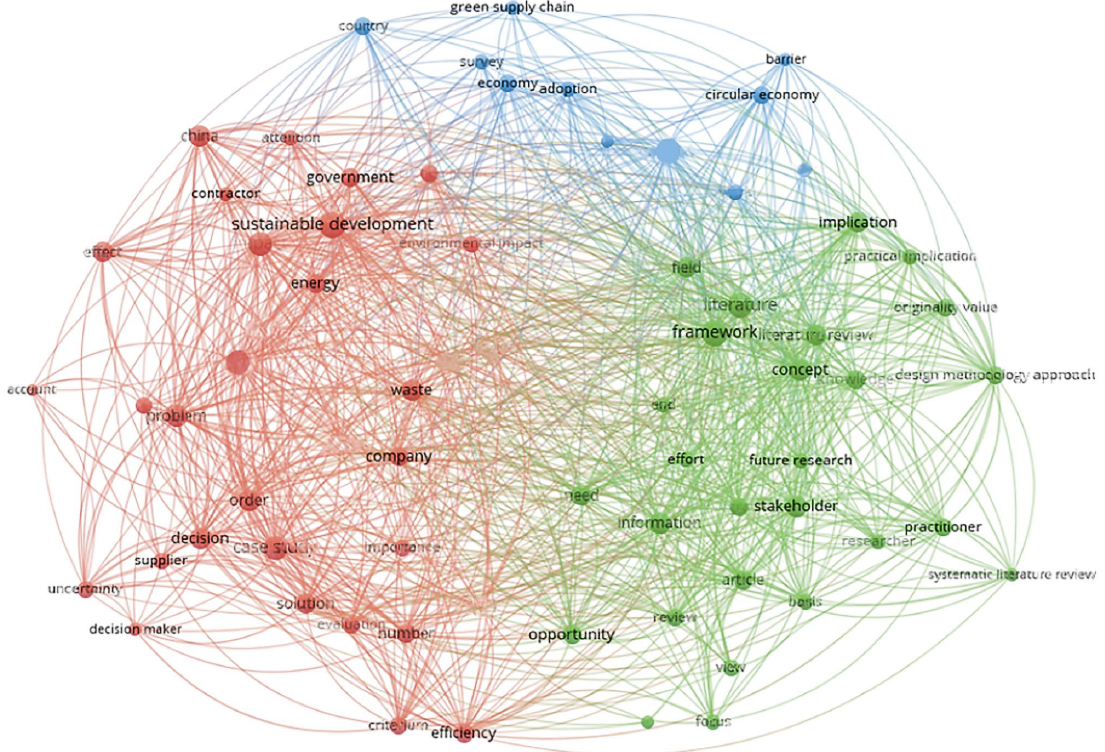
Figure 5. Keywords co-occurrence for sustainable supply chain management in